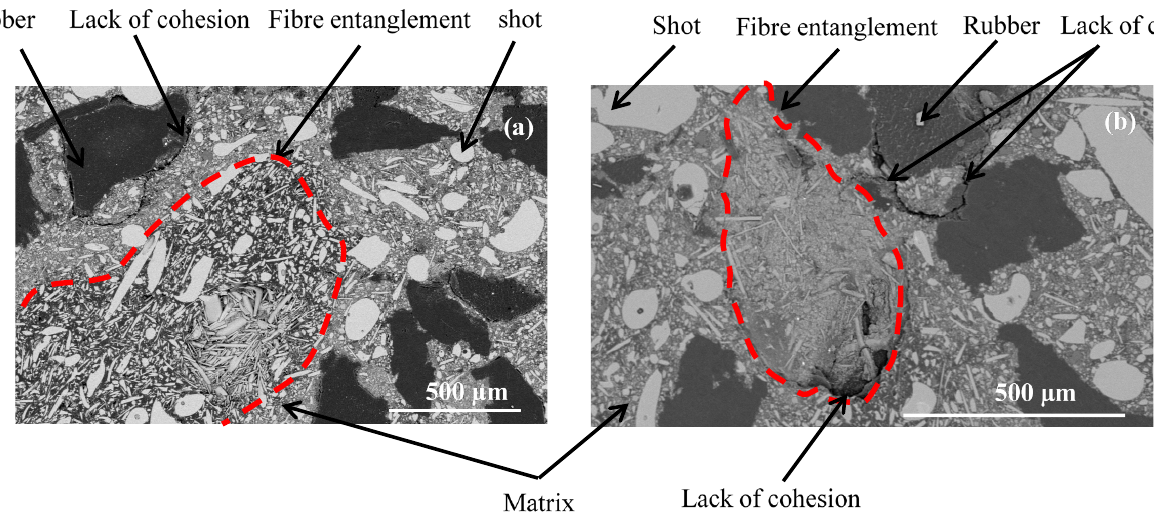
Figure 4. Microstructural defects in materials ( a ) M1 and ( b ) M2 (SEM-BSE).